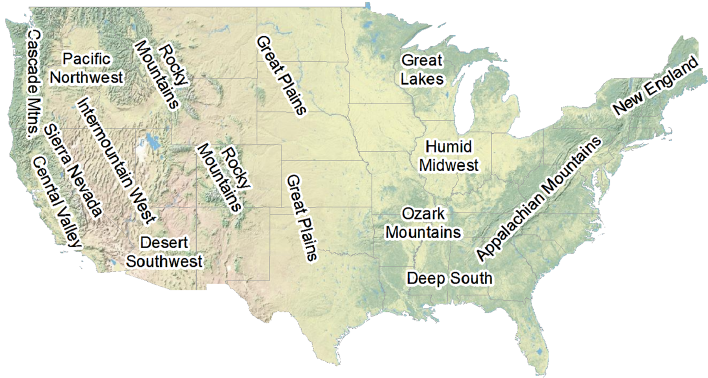
Figure 1. Location map of the conterminous US showing the different geographic regions referred to this